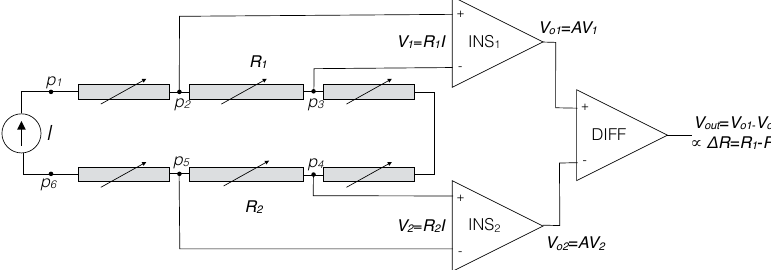
Figure 2. Electrical model of the KPF goniometer and schematic of the front-end of the acquisition electronics. The light grey boxes are strain-variable electrical resistances. A 4-wires resistance measuring method is employed: (i) a constant current ( I ) is supplied (pads p 1 and p 6 ); (ii) the voltages across the two sensing layers are measured ( p 1 − p 2 and p 4 − p 5 ) through the two instrumentation amplifiers ( INS 1 and INS 2 ), and (iii) the difference between the measured voltages—proportional to ∆ R —is performed through the differential amplifier ( DIFF